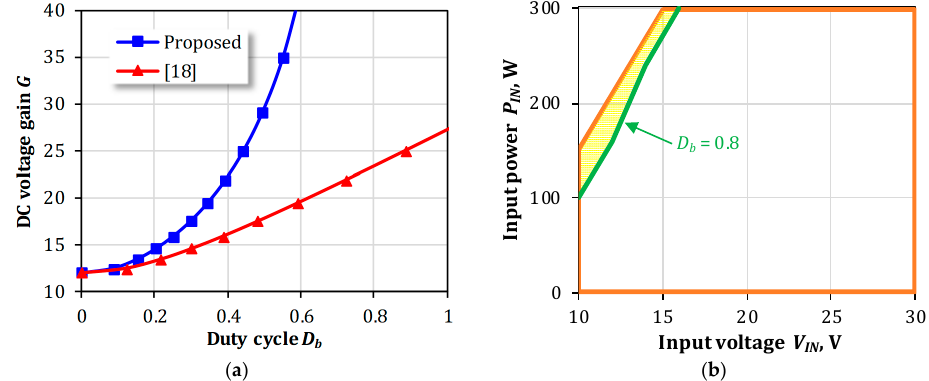
Figure 7. Comparison between the proposed topology and [18] in terms of ( a ) the DC voltage at P IN = 300 W and ( b ) target and feasible input voltage and power ranges for L r = 100 µH.